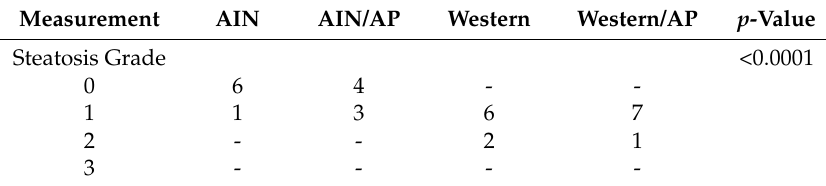
Figure 3. Representative histological staining images of livers of growing female rats consuming ( A ) AIN, ( B ) AIN/AP, ( C ) Western, or ( D ) Western/AP following eight weeks of feeding. Arrow indicates fat deposition. Scores analyzed by chi-square test at p < 0.05.